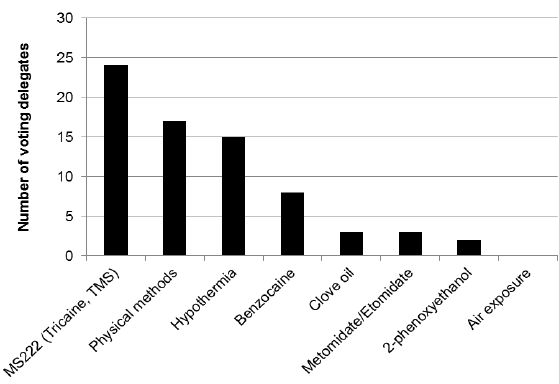
Figure 1. Meeting participants’ responses to the questions: “Which methods do you use to kill mice/rats?”.